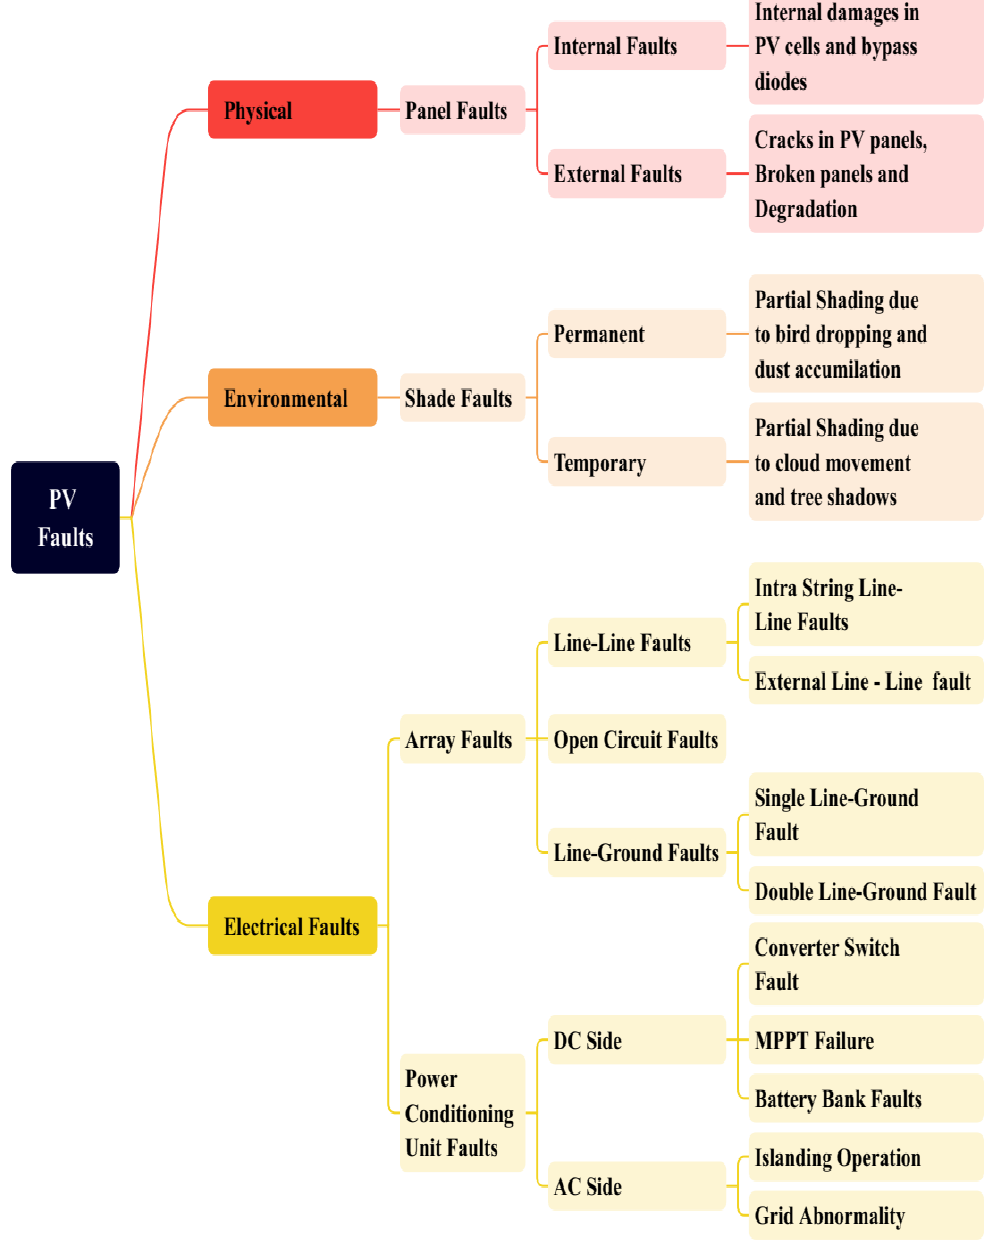
Figure 1. Classification of faults in PV systems.